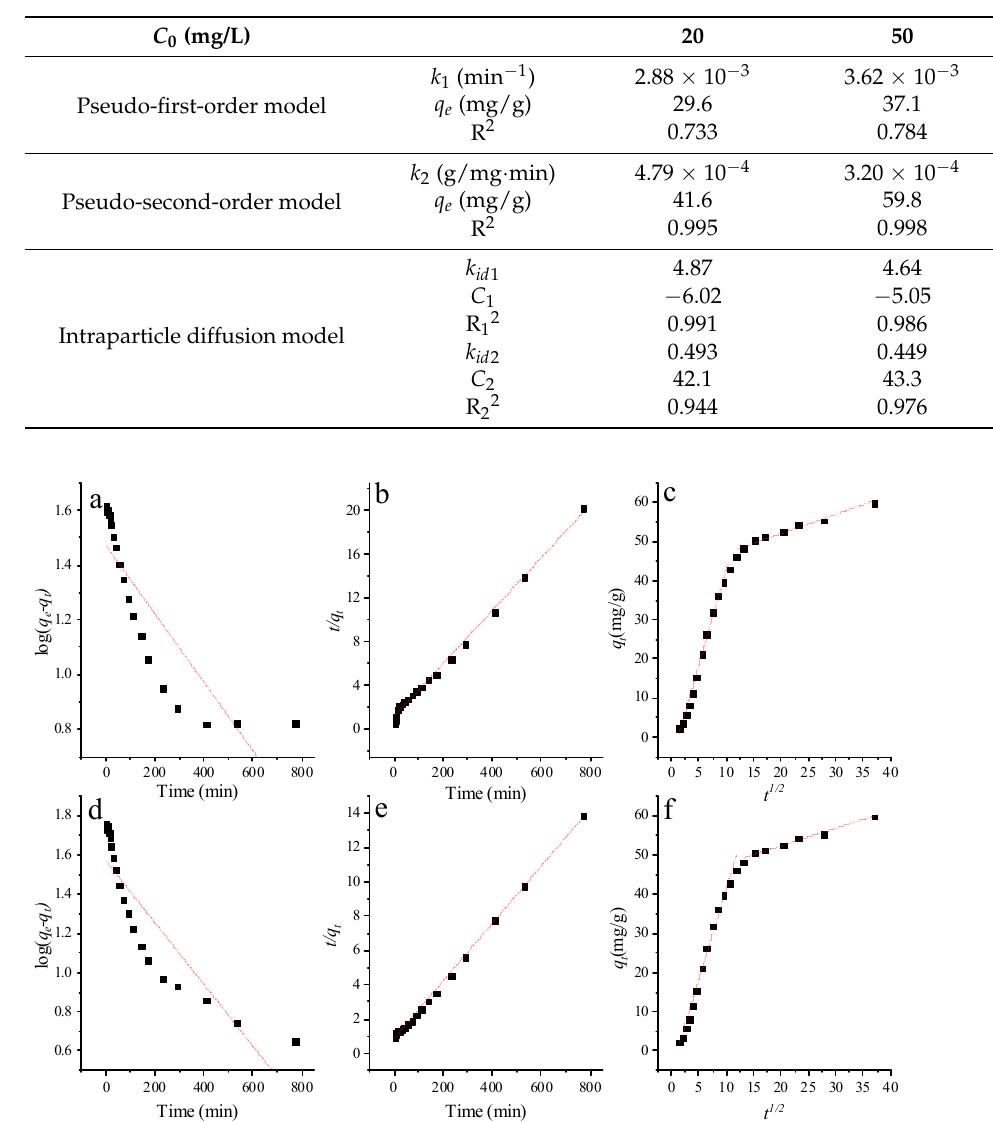
Figure 7. Adsorption kinetics of MB on PGO aerogel: ( a ) and ( d ) pseudo first-order model, ( b ) and ( e ) pseudo second-order model, and ( c ) and ( f ) intra-particle diffusion model.